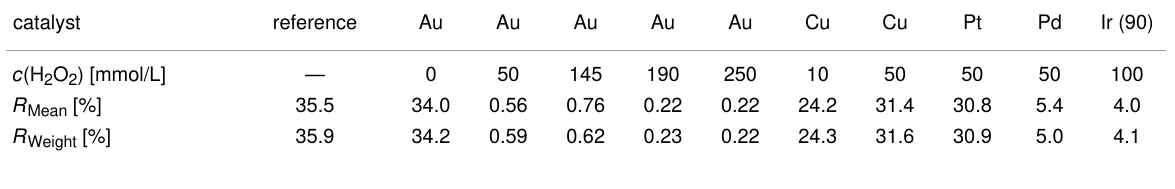
Table 1: Summary of reported samples including catalyst material, H 2 O 2 concentration, average reflectance ( R Mean ), and weighted average ( R Weight ).